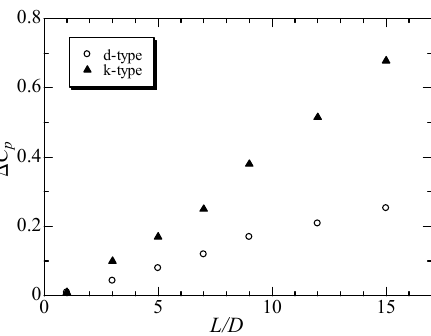
Fig. 5 Static pressure difference against two types of roughness varying in